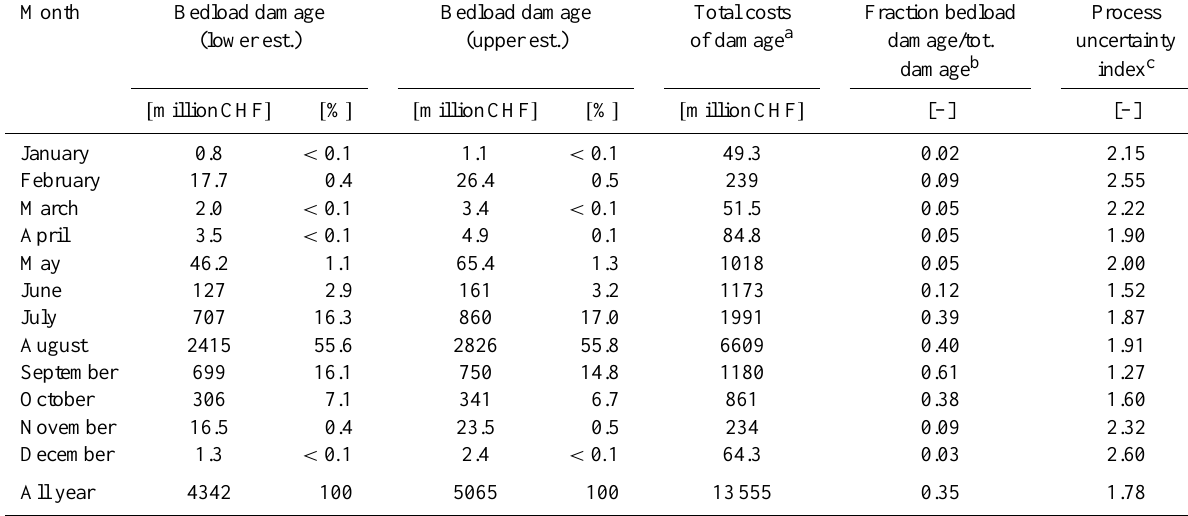
Table 2. Monthly distribution of the estimates of damage caused by bedload processes (cumulative data for the period 1972–2011). Month Bedload damage Bedload damage Total costs (lower est.) (upper est.)